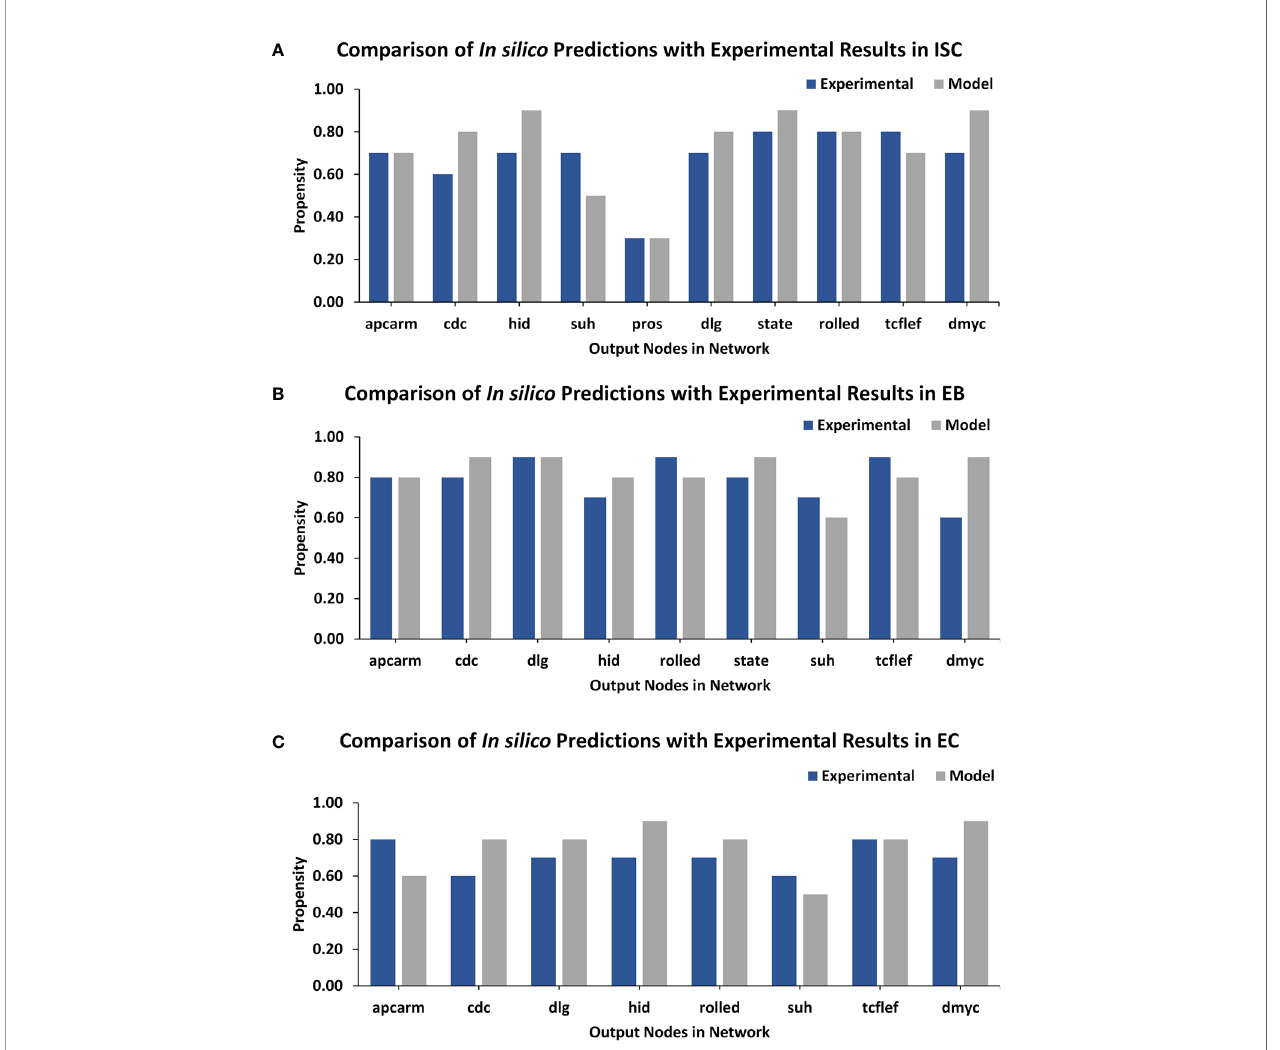
FIGURE 3 | TISON output nodes propensities ( in silico results) validation from FlyGut-seq database ( in vivo results). (A) Comparison of ten output nodes propensities in ISC network: adenomatous polyposis coli (Apc2), cdc42 (Cdc42), head involution defective (hid), suppressor of hairless (Su(H)), prospero (pros), discs large 1 (dlg1), signal-transducer and activator of transcription protein at 92E (Stat92E), rolled (rl), pangolin (pan), and dMyc (myc). (B) Comparison of nine output nodes propensities in EB network: adenomatous polyposis coli (Apc2), cdc42 (Cdc42), discs large 1 (dlg1), head involution defective (hid), rolled (rl), signal- transducer, and activator of transcription protein at 92E (Stat92E), suppressor of hairless (Su(H)), pangolin (pan), and dMyc (myc). (C) Comparison of eight output nodes propensities in EC network: adenomatous polyposis coli (Apc2), cdc42 (Cdc42), discs large 1 (dlg1), head involution defective (hid), rolled (rl), suppressor of hairless (Su(H)), pangolin (pan) and dMyc (myc) ( Supplementary Table 10